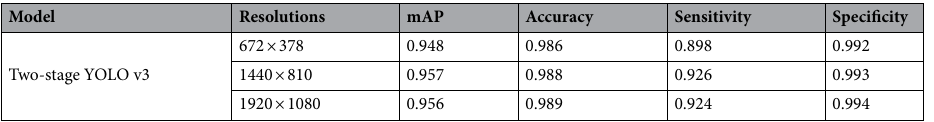
Table 5. Detection success based on different pixel resolutions. The original images had a pixel resolution of 1920 × 1080 pixels. These were rescaled to 672 × 378 and 1920 × 1080 pixels before the comparative model testing was